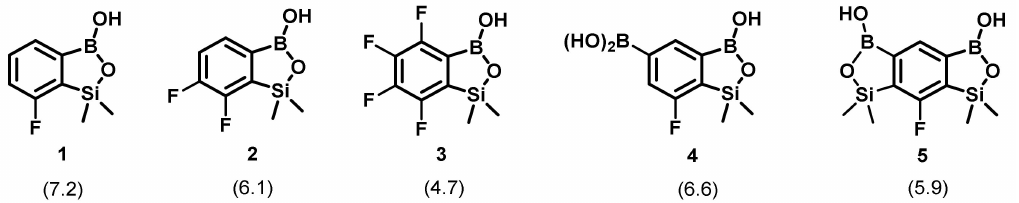
Figure 1. Structures of fluorinated benzosiloxaboroles 1 – 5 (the p K a values determined in [12] are given in